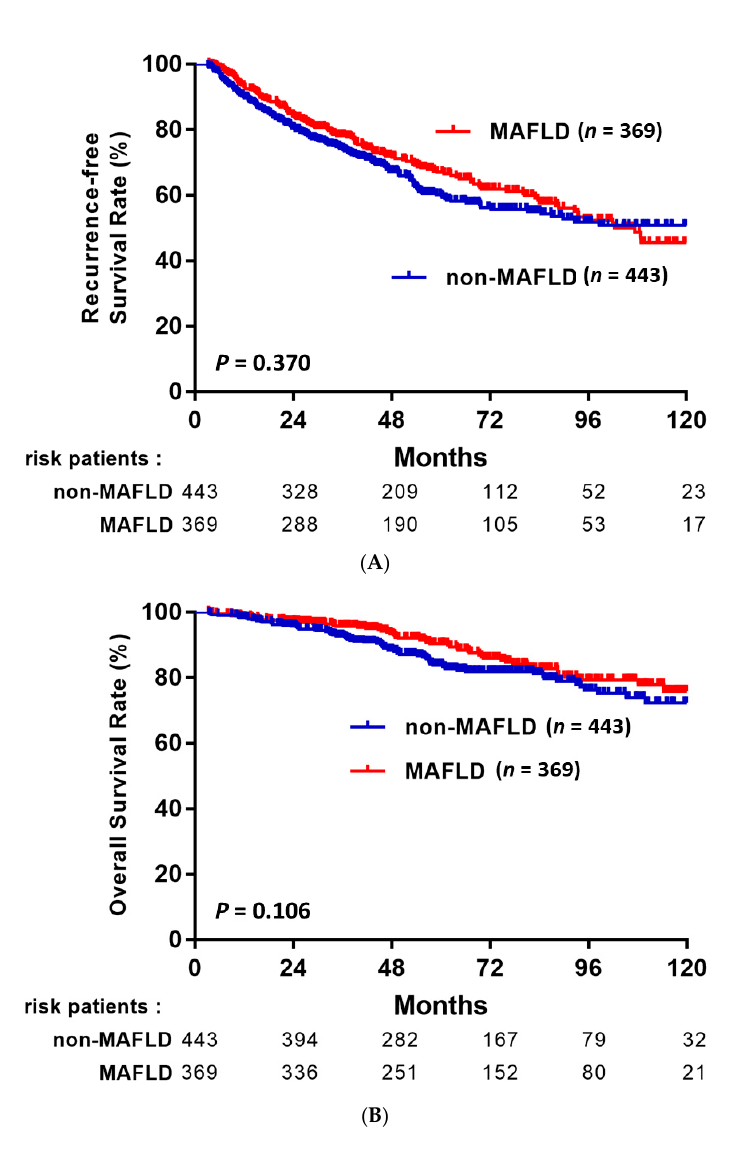
Figure 2. RFS ( A ) and OS ( B ) after curative resection in patients with HBV-related HCC with or without MAFLD.